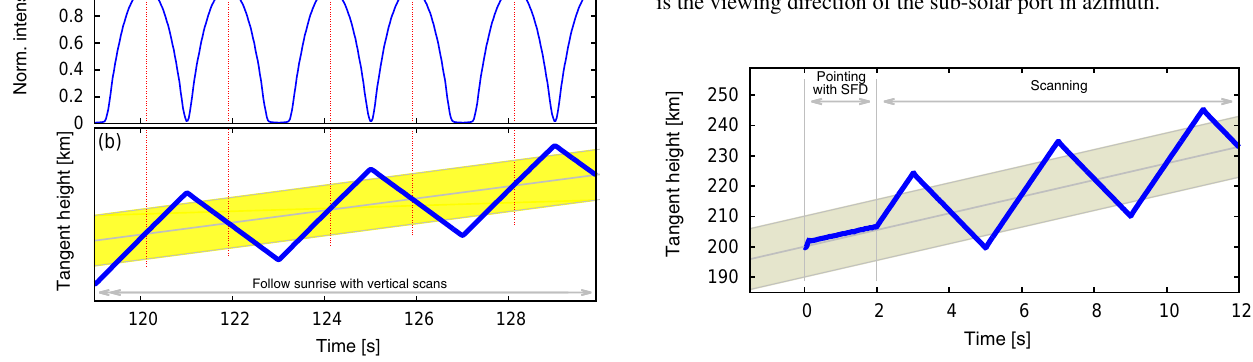
Figure 4. Sun over sub-solar port measurement sequence. (b) After an initial phase of waiting for the sun, the SFD tracks the sun in elevation. (a) The ASM mirror is not in the light path. The azimuth angle of the solar disk is changed by the orbital motion of the plat- form. At maximum intensity, the azimuth angle is 270 ◦ because that is the viewing direction of the sub-solar port in azimuth.